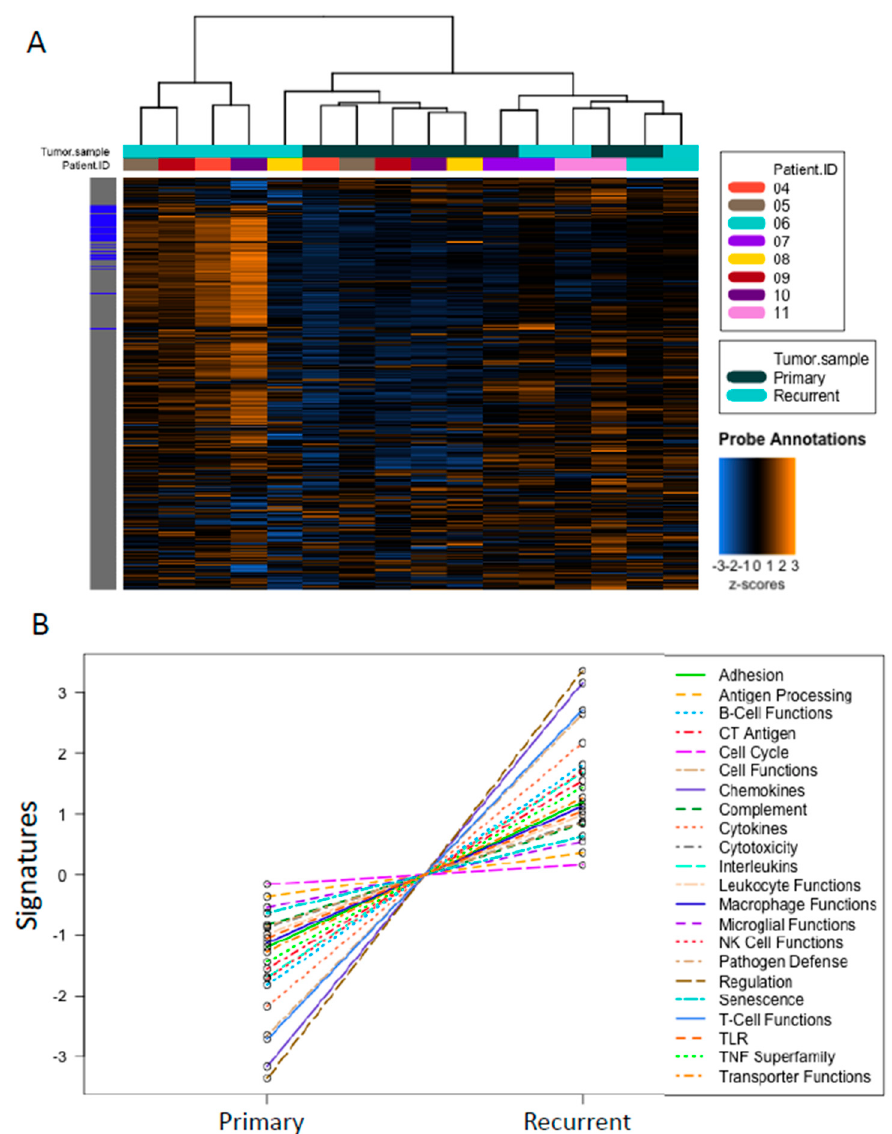
Figure 3. NanoString analysis of primary vs. recurrent tumor samples. ( A ) Heatmap showing all genes analyzed with NanoString technology. Samples are clustered together based on expression patterns. Gene expression levels are illustrated with a Z score. Orange indicates high expression; blue indicates low expression. ( B ) Illustrating the change in the pathway signatures from primary to recurrent tumors using nSolver software.